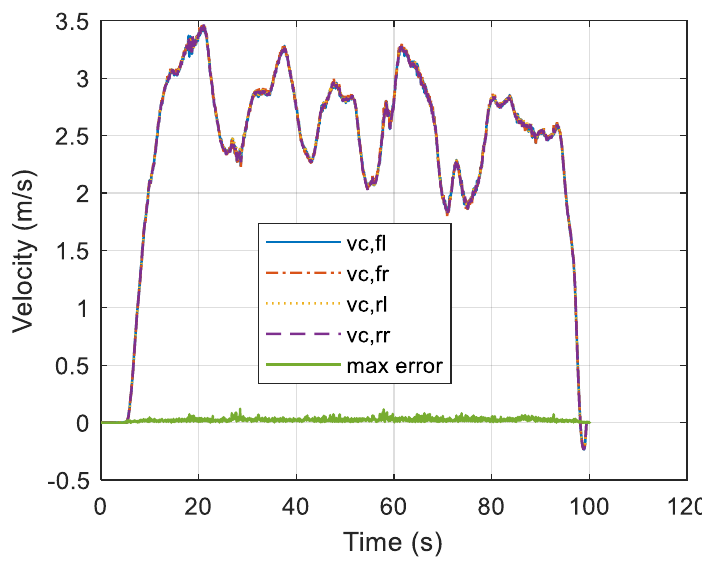
Figure 5. Central axis speeds as functions of time.